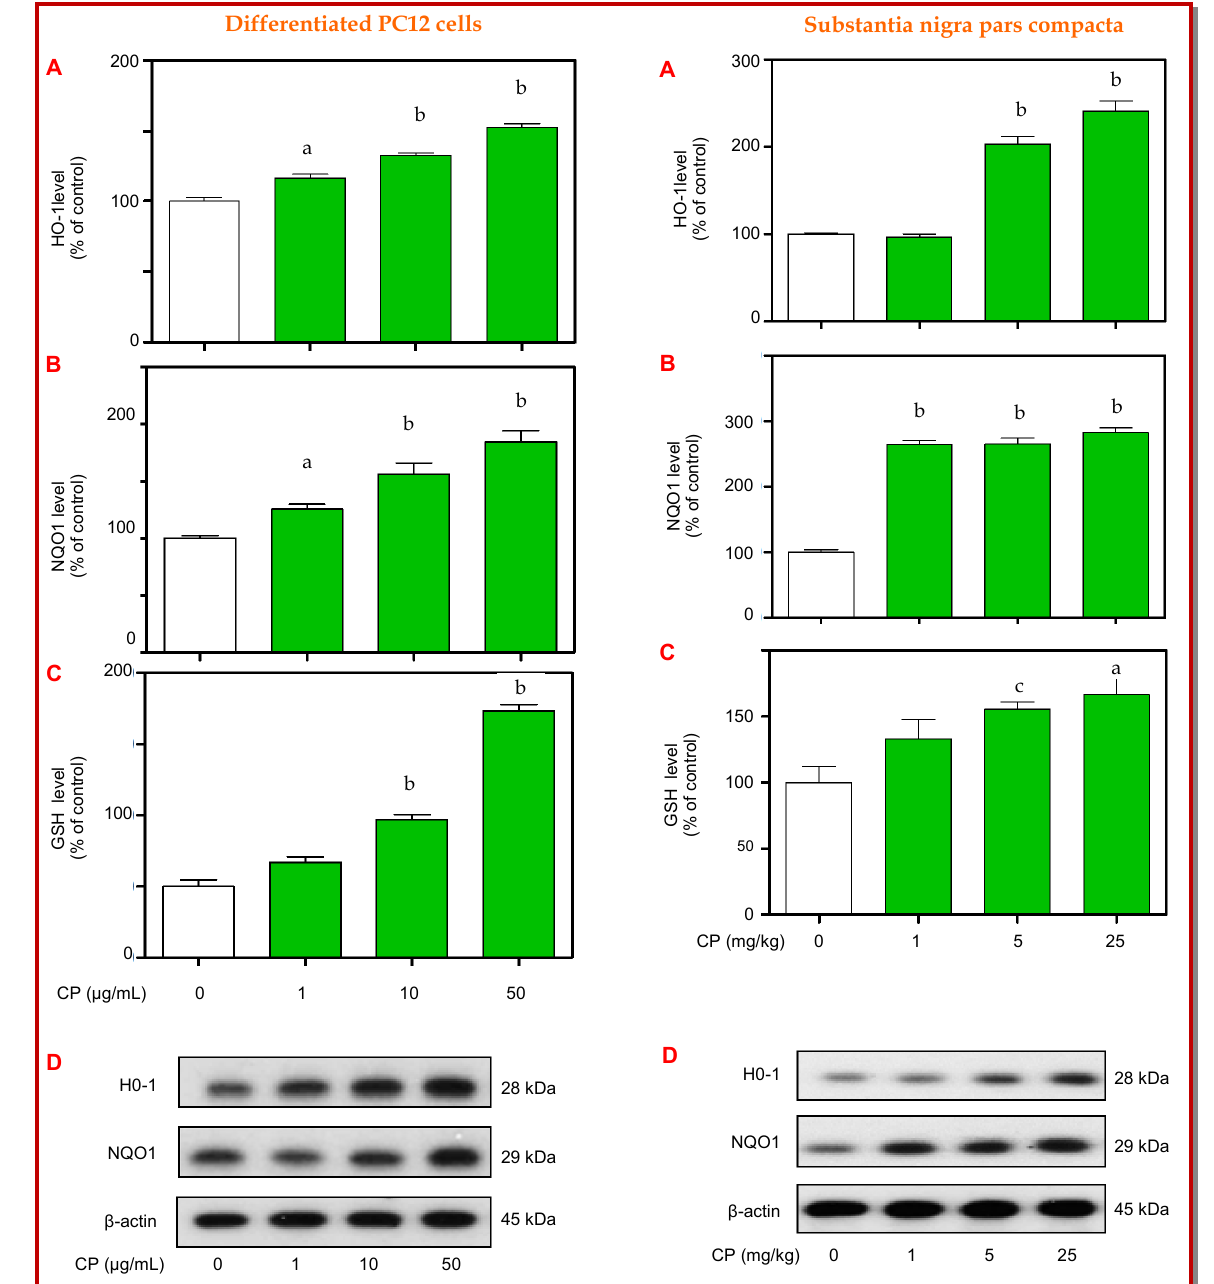
Figure 3: Effects of Cicadidae Periostracum (CP) on oxidative defense protein levels using differentiated PC12 cells and substan- tia nigra pars compacta. Levels of (A) heme oxygenase-1 (HO-1) and (B) quinone oxidoreductase 1 (NQO1) were measured by Western blotting and normalized to β -actin. (C) Glutathione (GSH) levels were measured by an enzyme-linked immunosorbent assay. (D) Representative western blot. a p<0.01, b p<0.001 and c p<0.05 compared with the control